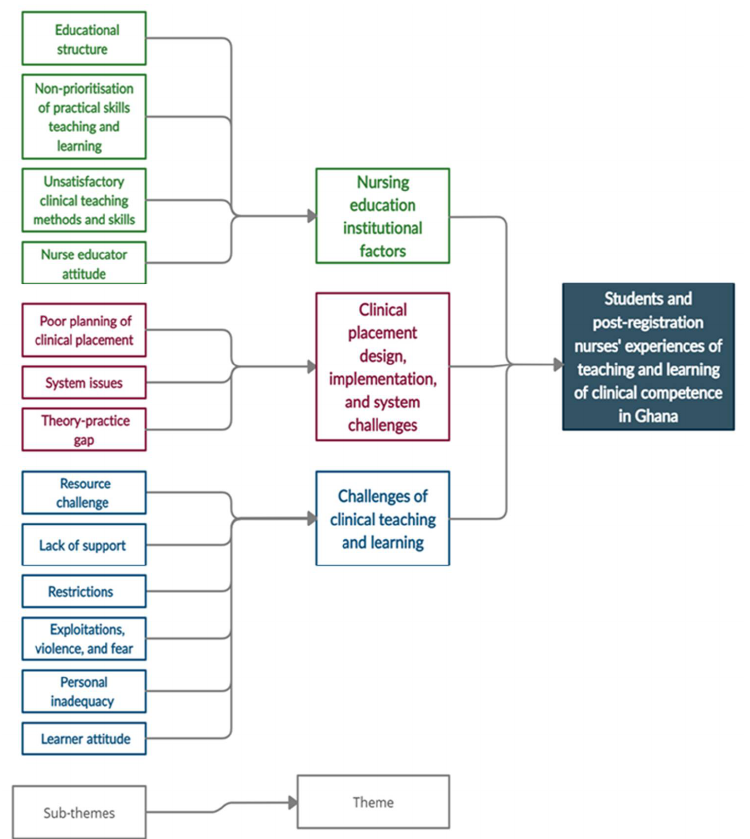
Figure 1. Sub-themes and themes based on students and post-registration nurses’ experiences of teaching and learning of clinical competence in Ghana. teaching and learning of clinical competence in